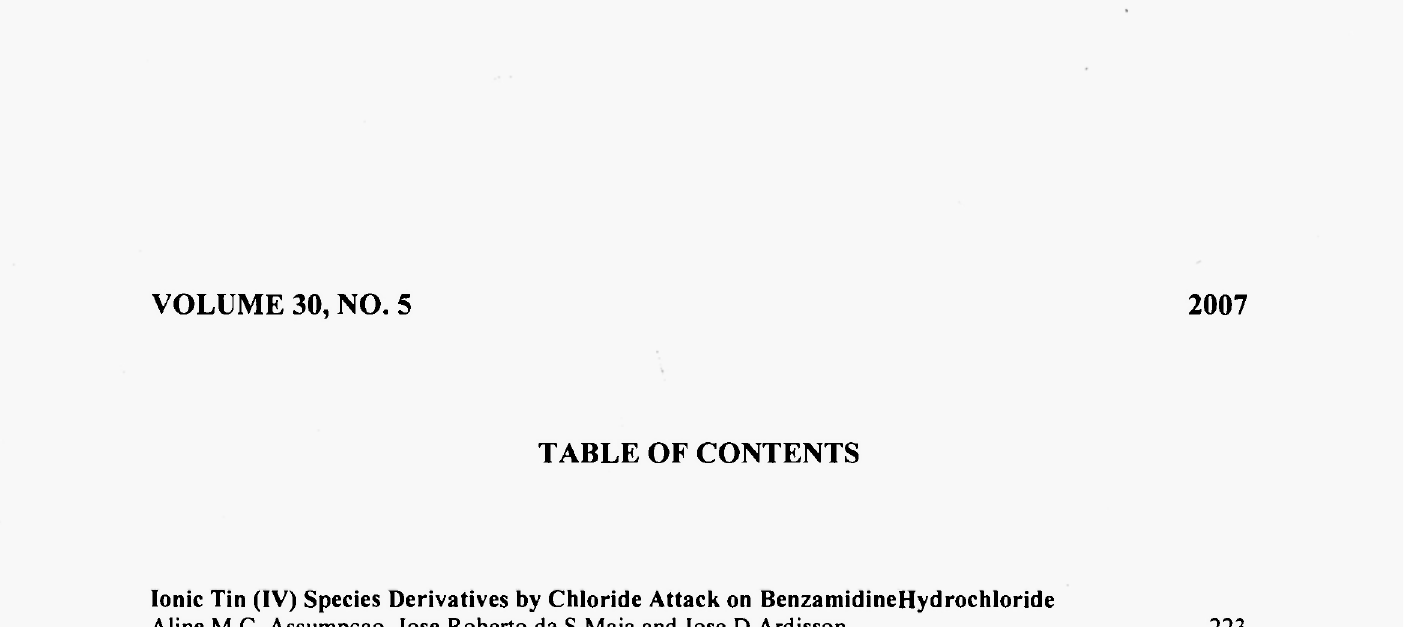
Ionic Tin (IV) Species Derivatives by Chloride Attack on BenzamidineHydrochloride Aline M.C. Assumpcao, Jose Roberto da S.Maia and Jose D.Ardisson An X-ray Crystallographic Study of New Monoclinic Selenium Allotrope 6-Se